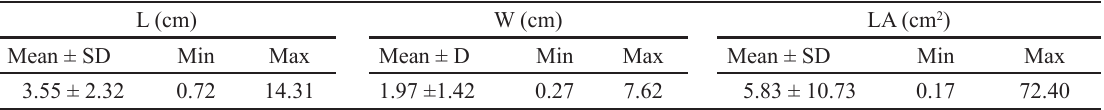
Table 1. Means ± standard deviations (SD), minimum (min), maximum (max) values for the leaf length (L), width (W), and leaf area (LA) of the Eugenia uniflora L.